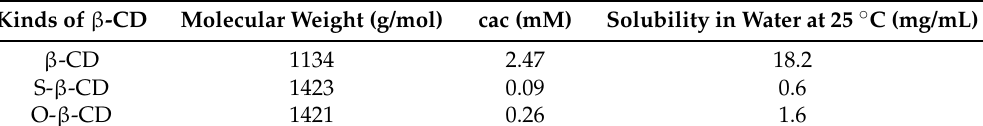
Table 1. Physicochemical properties of β -CD, S- β -CD, and O- β -CD.